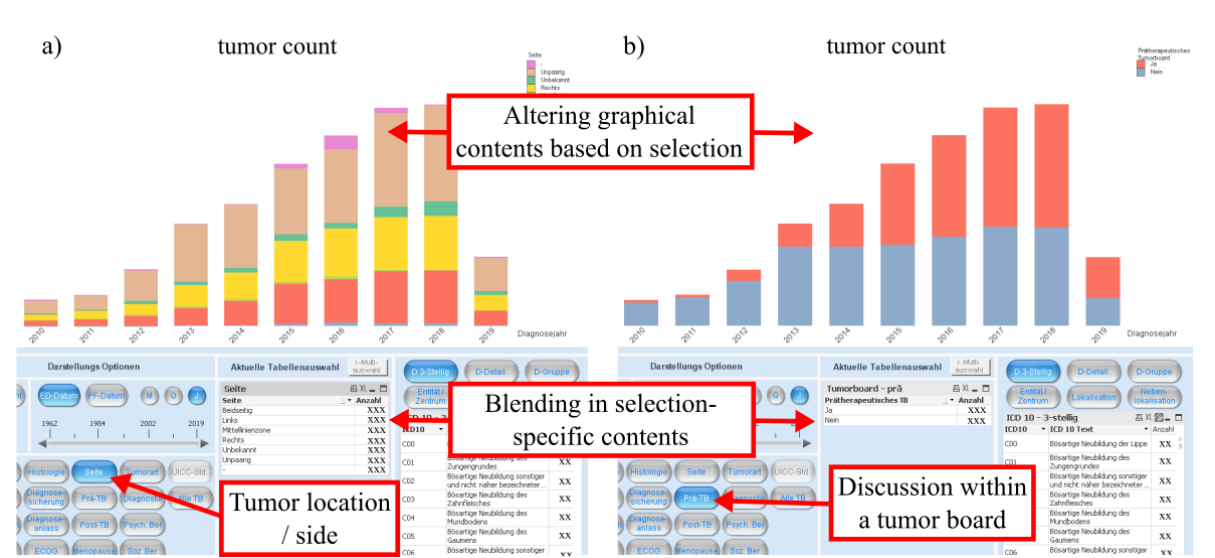
Figure 2. The image (screen language in German) displays two different selections within the first assessment (diagnosis) view. By simply clicking on different buttons, in this case “tumor location/side” in (a) and “discussion of a chosen case within a tumor board” in (b), it is possible to specifically select and examine the number of cancer cases with the chosen feature (in the chart stratified by date of